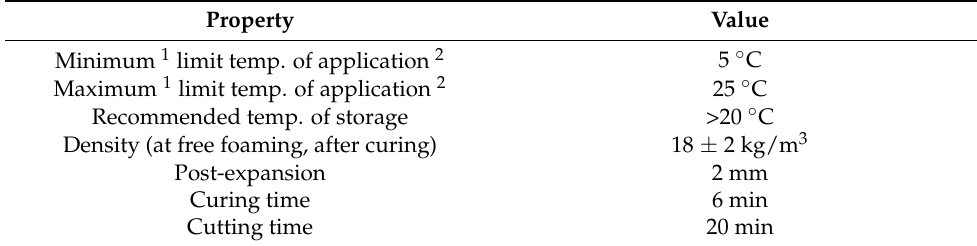
Table 2. Polyurethane adhesive working